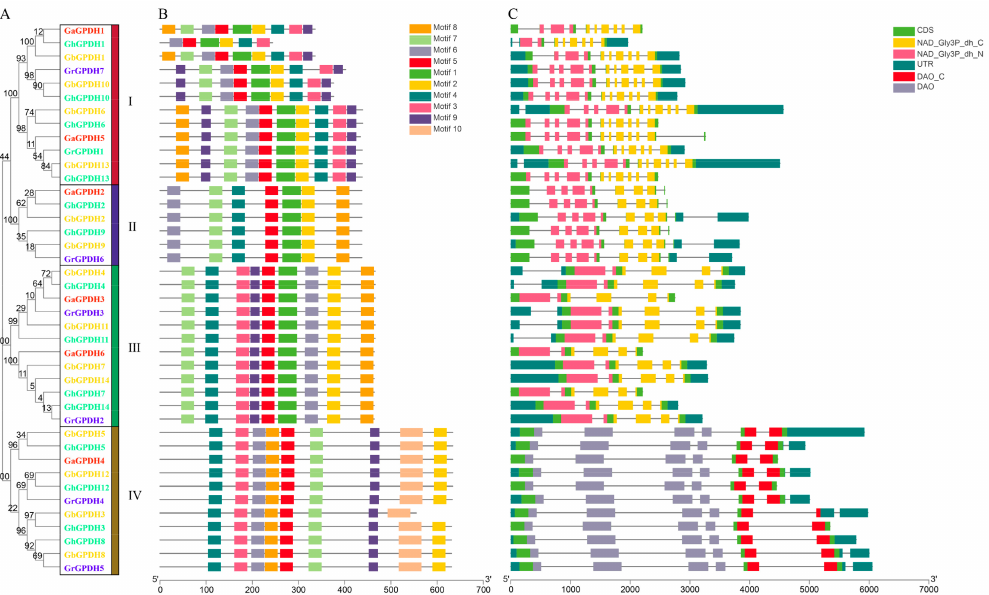
Figure 1. Phylogenetic relationships, motifs and structures of GPDH genes in cotton. ( A ) Evolutionary relationships. The evolutionary tree was constructed with 41 GPDH members in cotton. The four groups are divided by different colors, and different colored IDs represent different cotton species. ( B ) Ten conserved motifs were identified in cotton, with the different colored boxes representing different motifs. ( C ) Genetic structure and conserved domain